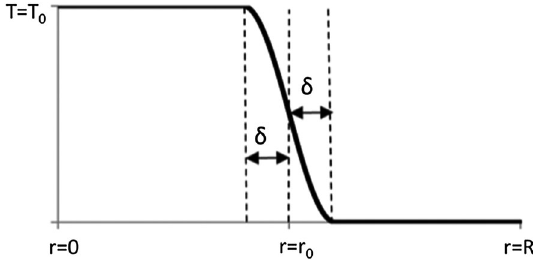
FIG. 2. Continuous initial condition as employed by Zheng et al.